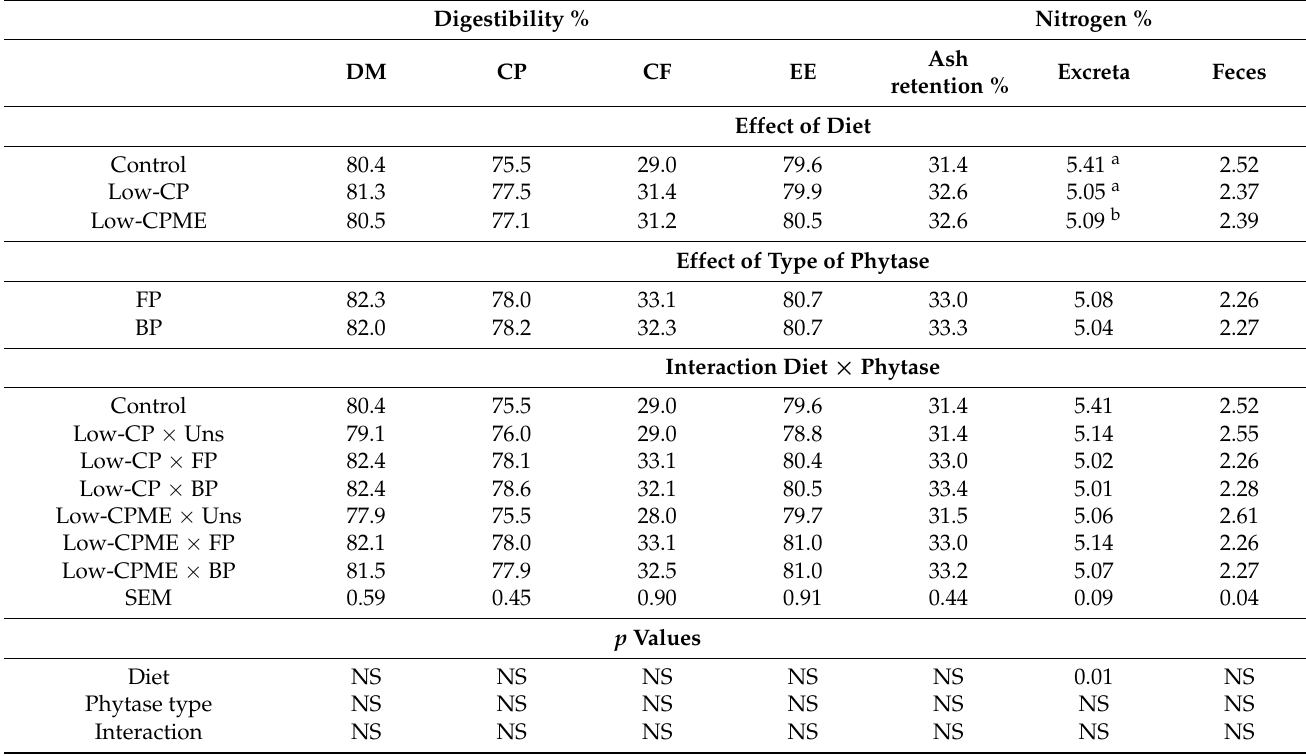
Table 3. Effect of diet, type of phytase, and their interaction on nutrient digestibility, ash retention and fate of